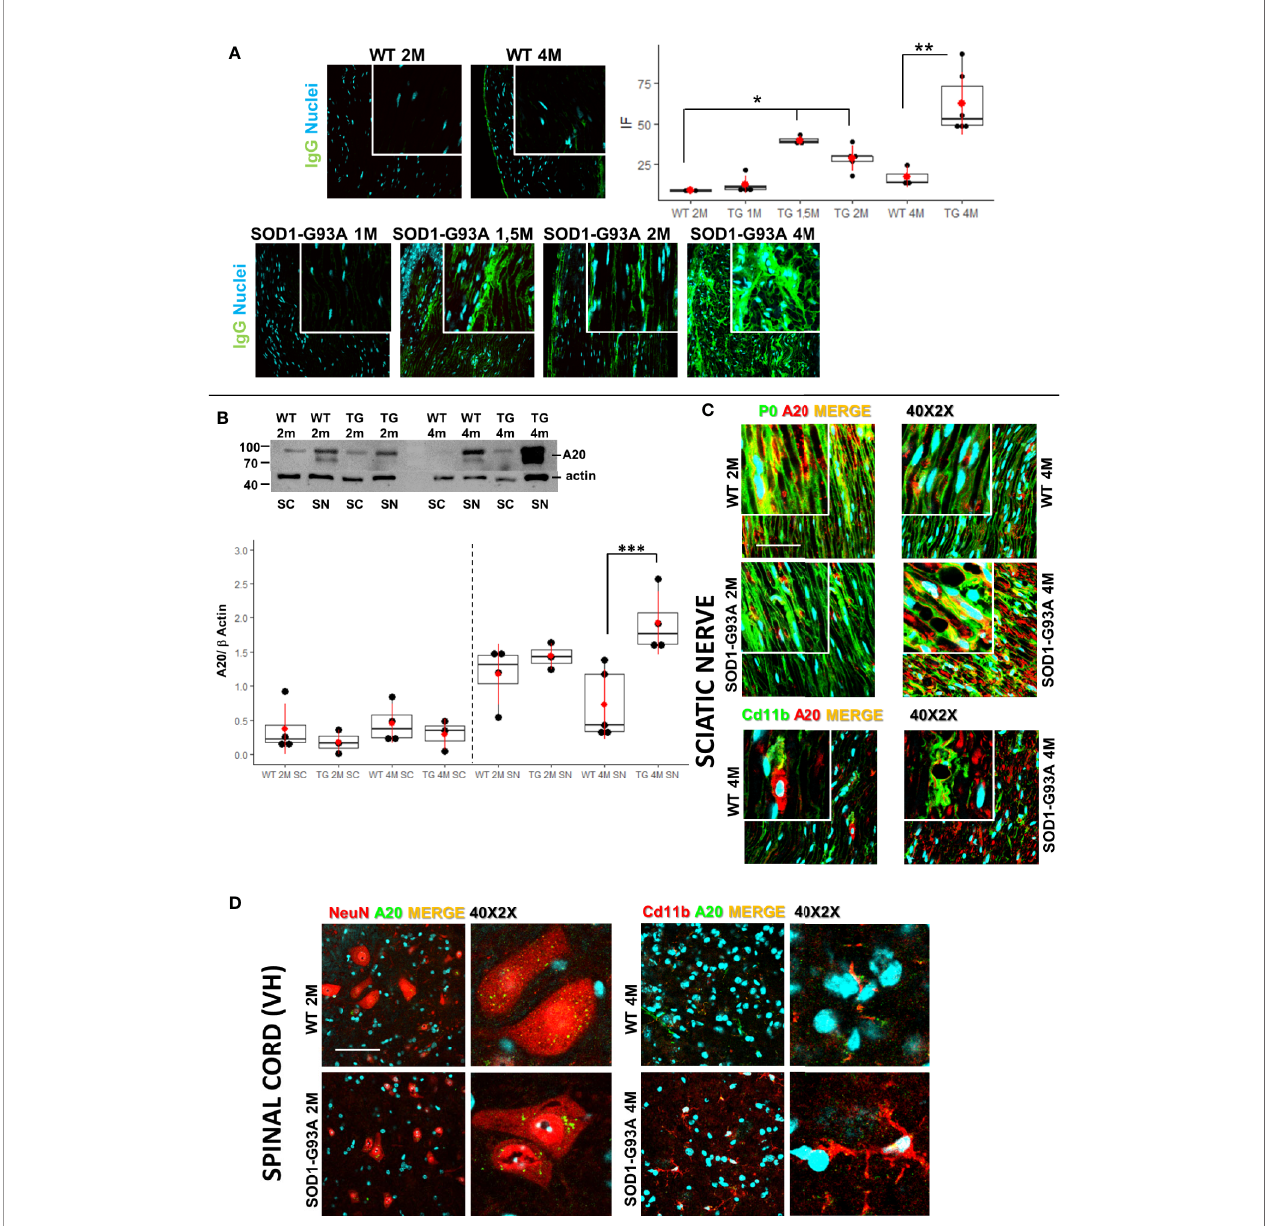
FIGURE 5 | Early detection of immunoglobulins and A20 expression. (A) IgGs detection (green) in sciatic nerves of 2 (2M) and 4 months (4M) WT mice compared with the IgGs presence in 1, 1,5, 2, and 4 months old SOD1-G93A mice. Dunn-Test post-hoc * vs WT 2M p <0.05; ** vs WT 4M p <0.01. (B) Western blot analysis of A20 levels in sciatic nerve (SN) and spinal cord (SC) in 2 (2M) and 4 months (4M) old WT and SOD1-G93A (TG) mice. Dunn Test post-hoc ***vs WT 4M p <0.00; 3 – 4 experiments/group, each WB at least 3 different animals. (C) Confocal sample images of A20 (red) localization and distribution co-stained with myelin protein P0 (green) or macrophages (Cd11b – green) in sciatic nerves of 2 or 4 months old WT and SOD1-G93A mice. (D) Confocal sample images of A20 (green) distribution and localization co-stained with neurons (NeuN – red) or microglia (Cd11b – red) in spinal cord of 2 or 4 months old WT and SOD1-G93A